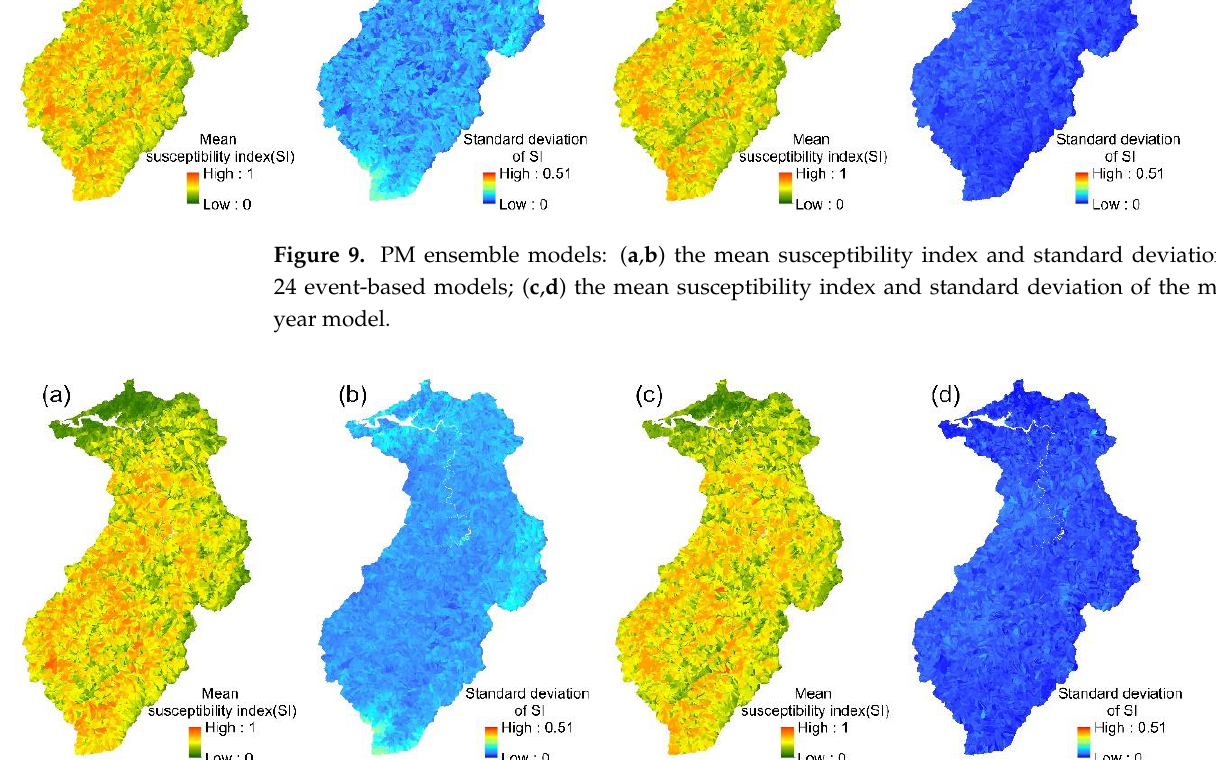
Figure 10. PME ensemble models: ( a , b ) the mean susceptibility index and standard deviation of 24 event-based models; ( c , d ) the mean susceptibility index and standard deviation of the multi-year model.